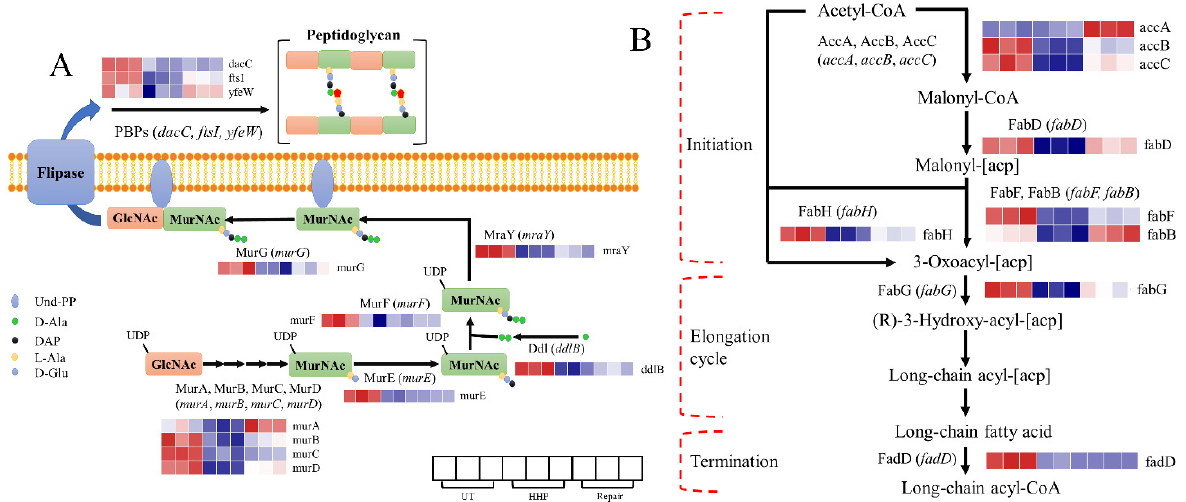
Figure 5. Transcriptional changes of genes involved in the significantly enriched pathway. ( A ) The peptidoglycan biosynthesis pathway. ( B ) The fatty acid biosynthesis pathway.